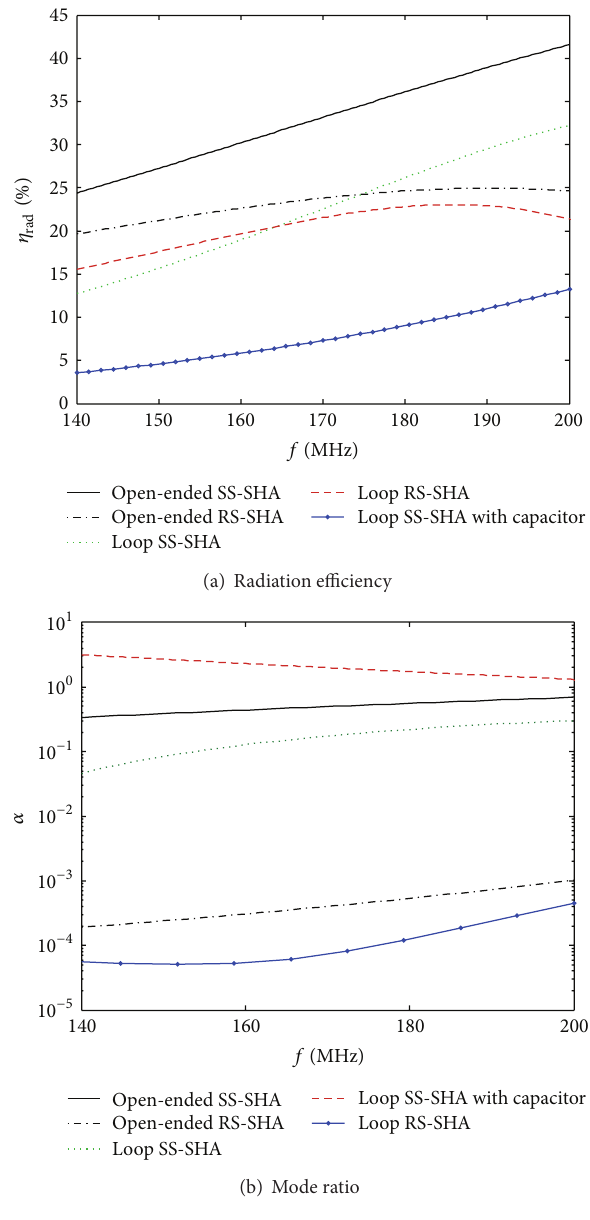
Figure 8: Radiation properties of examined SHAs from Table 3 versus